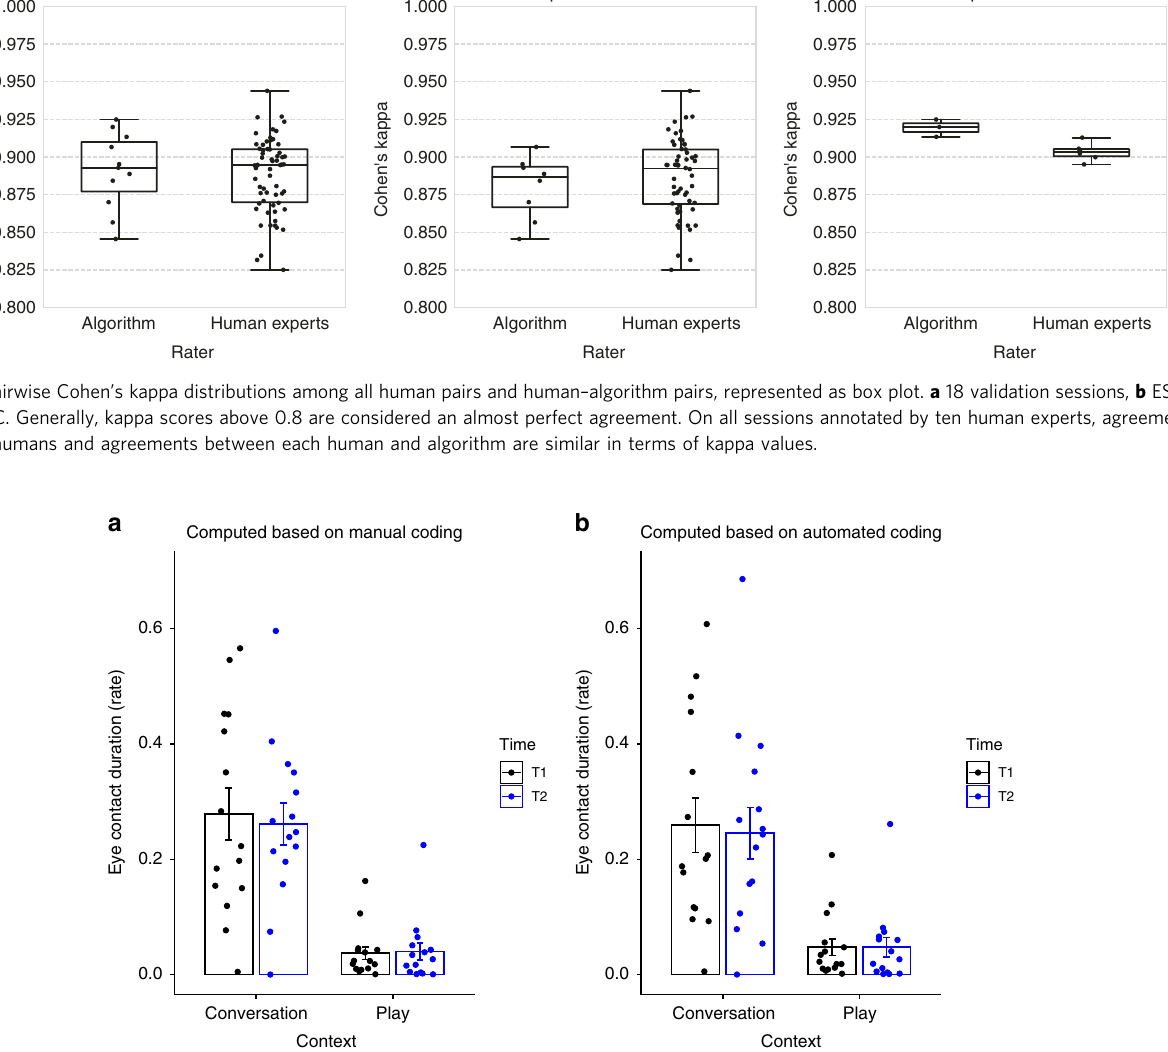
Fig. 4 Average duration of eye contact during conversation and interactive play in child and adolescent samples ( n = 15), measured at time 1 and time 2. a based on human coding, b based on automated coding. Data are presented as mean values ± SEM.